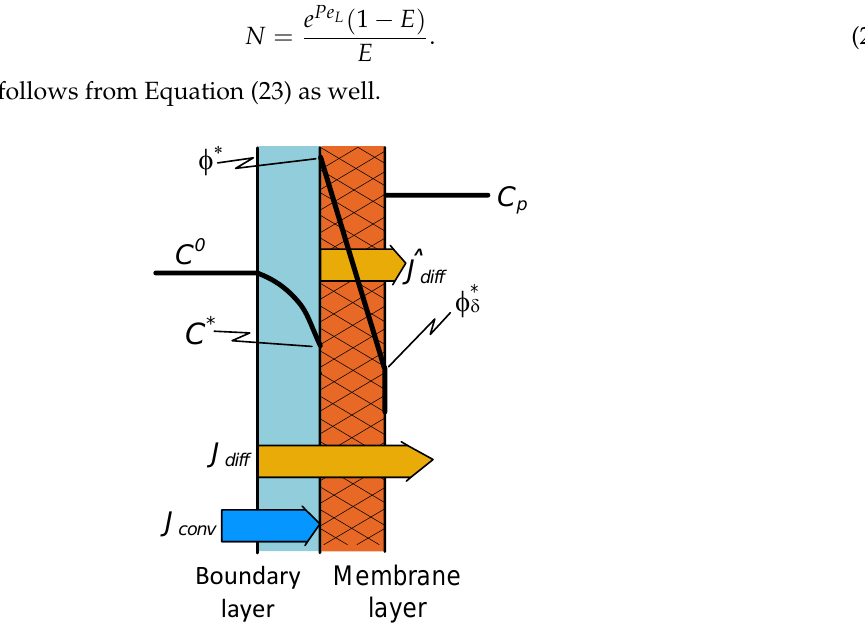
Figure 2. Schematic illustration of the concentration distribution for the case of a dense membrane with an “enriched” solute component .